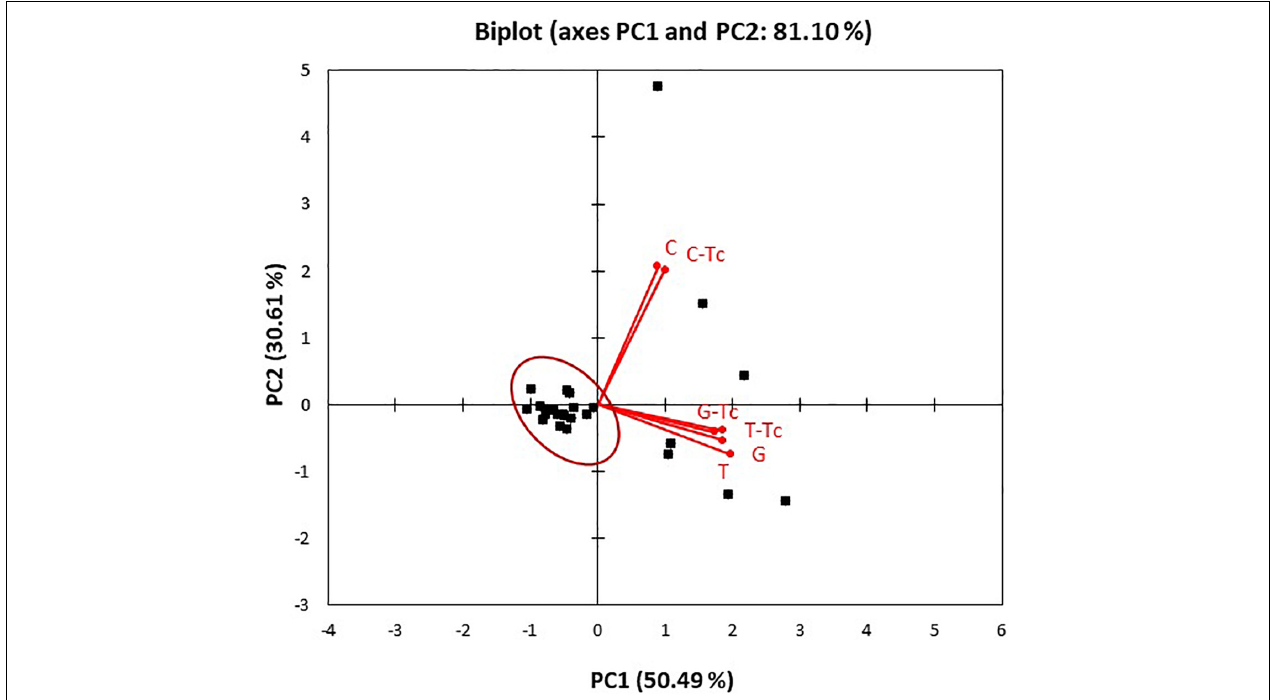
FIGURE 1 | Principal component analysis (PCA) biplot (scores and loadings) based on antibacterial activity of Coridothymus capitatus , Eugenia caryophyllata , and Thymus vulgaris EOs alone or in combination with tetracyclines on the Salmonella strains. C. capitatus (C), E. caryophyllata (G), T. vulgaris (T), and tetracycline